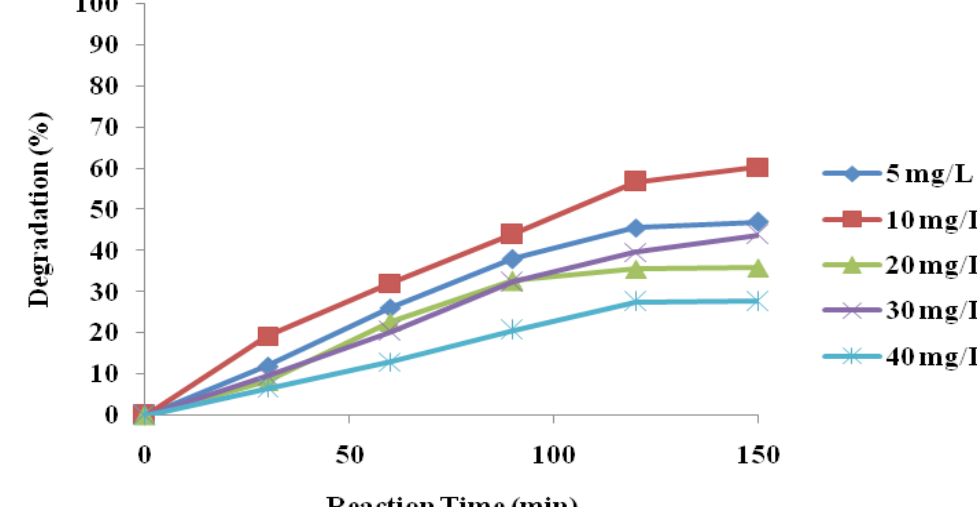
Fig. 5. Photo-catalytic degradation of methyl orange: effect of dye conce- ntration.